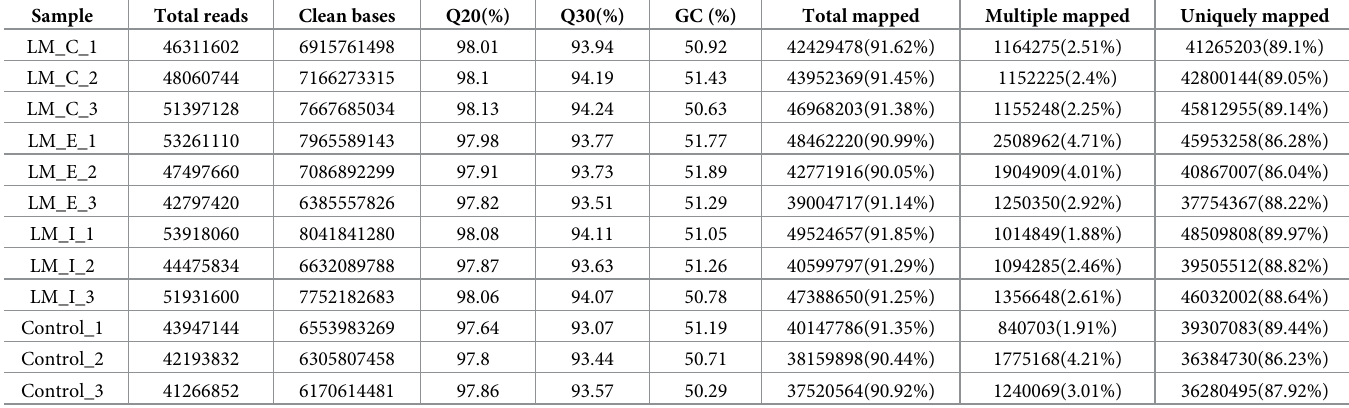
Table 1. Raw RNA-seq data from the LM-C, LM-E, LM-I and control groups with three replicates.